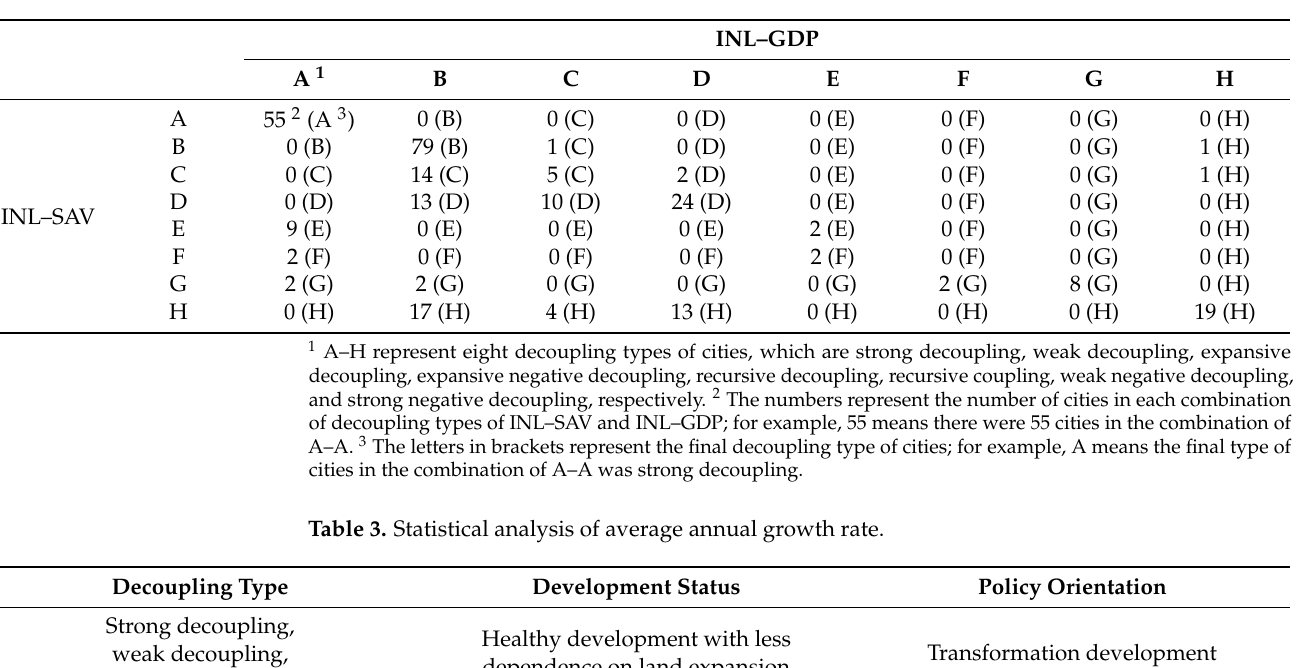
Table 2. Statistical analysis of average annual growth rate.